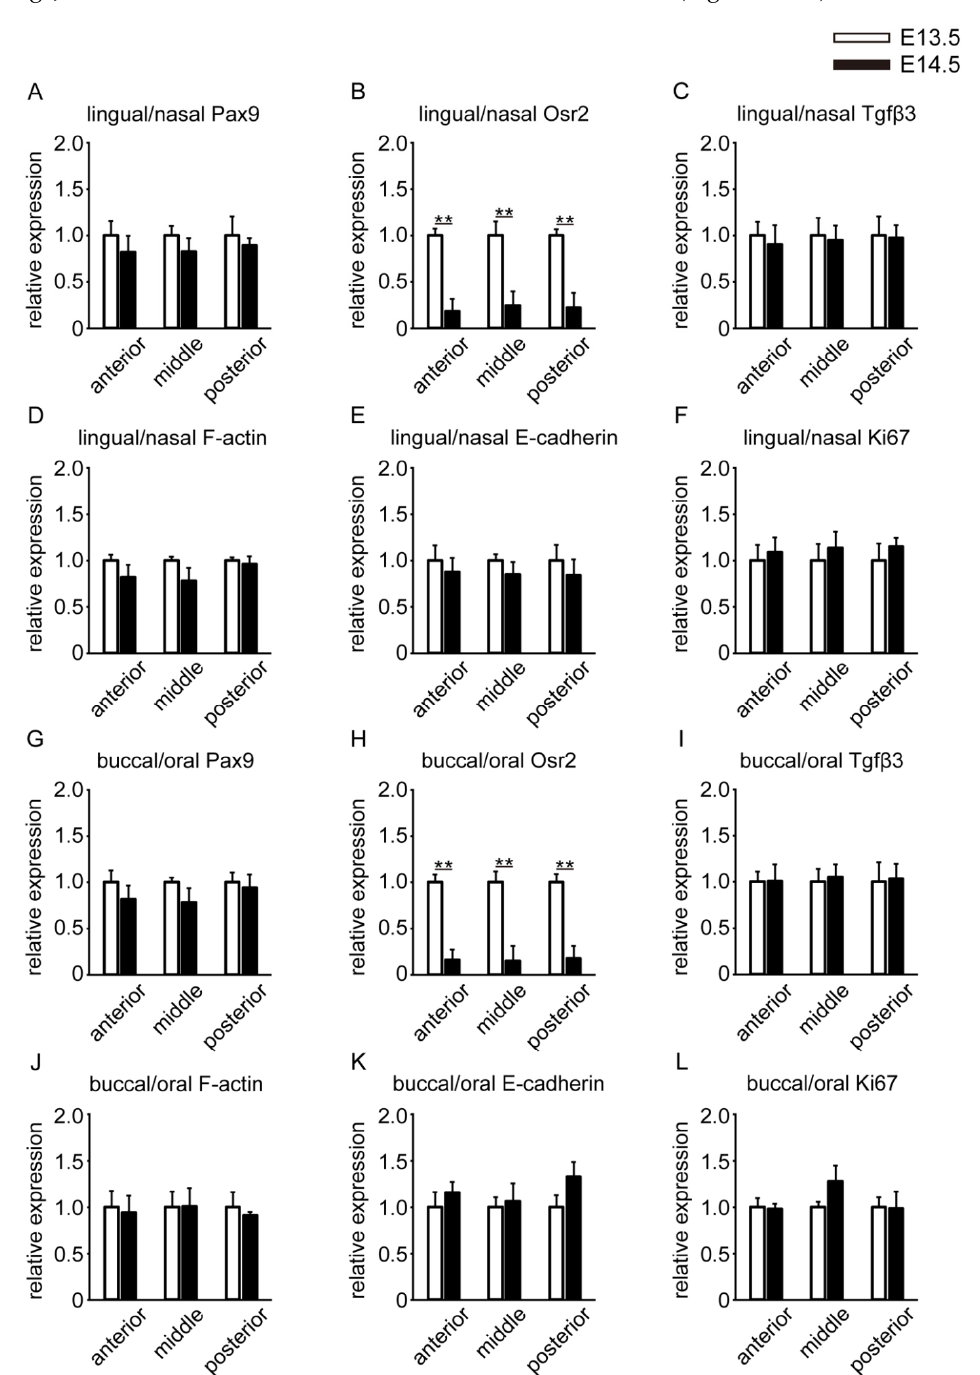
Figure 5. Temporal differences in anterior-to-posterior parts of the palatal shelf in both ( A – F ) lin- gual/nasal and ( G – L ) buccal/oral regions through an RT–PCR assay. The results are expressed as the fold change in gene expression compared to E13.5 as a control and are presented as the mean ± SEM ( n = 5). Student’s t -test was used to analyze the difference. ** p < 0.01 was considered statistically